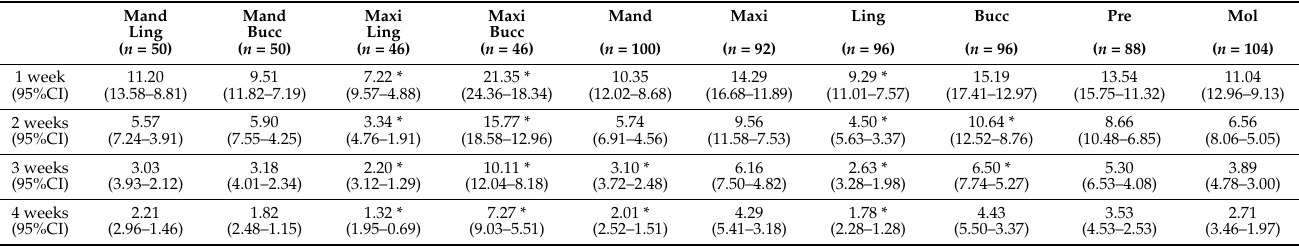
Table 3. The average Hybrid Coat adhesion rate (%) by the